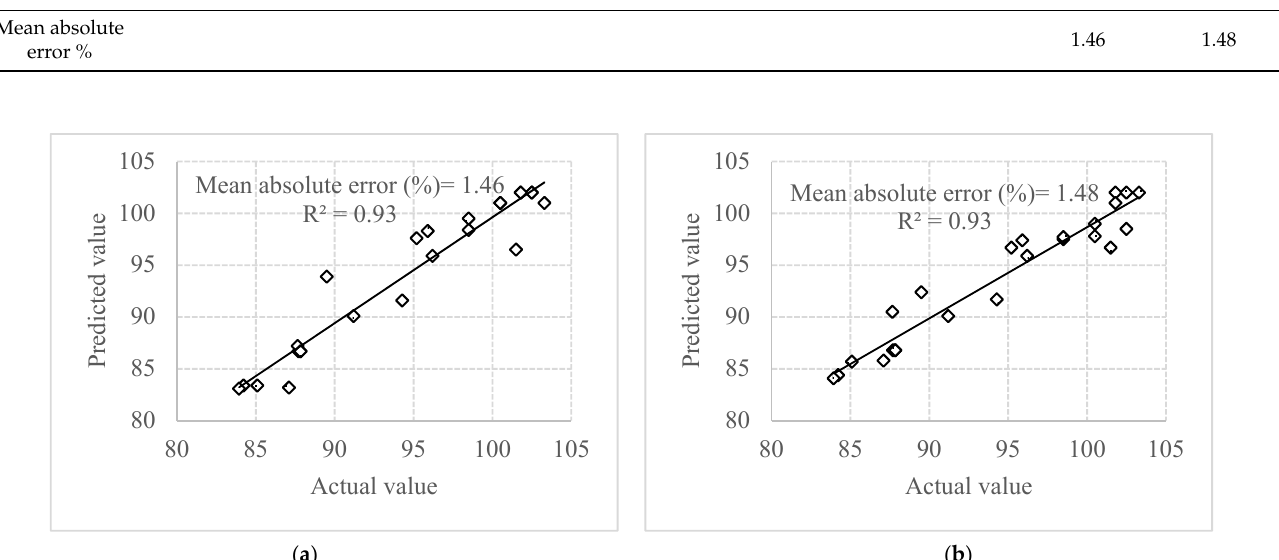
Figure 11. Correlation between actual and predicted yarn quality ratio using triangular membership function ( a ) and gaussian membership function ( b ).